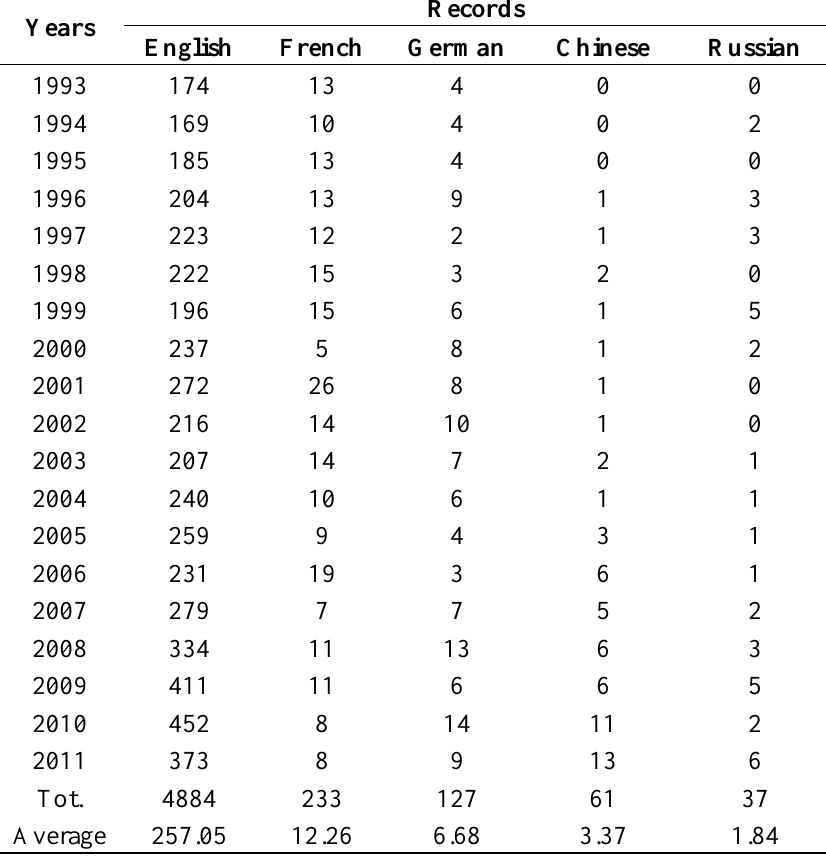
Table 3. Year-wise cumulative publications of the top five languages (English, French, German, Chinese, and Russian) on Buddhism and Buddhist studies from 1993 to